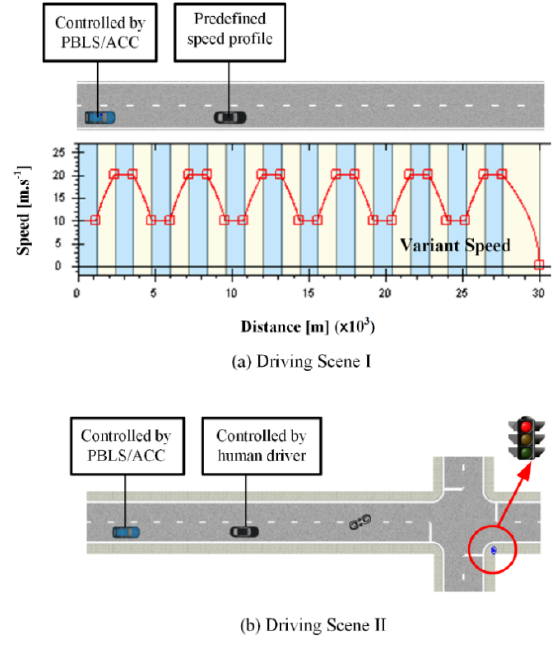
Figure 6. Driving scenes for variant speed scenarios.